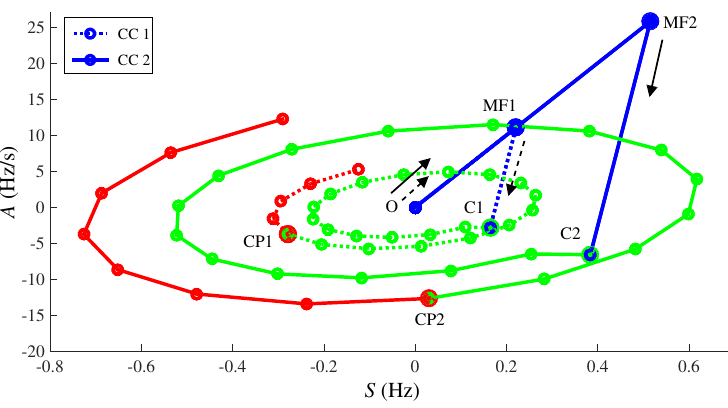
Figure 7. A k ( S k ) trajectories for contingencies CC 1 and CC 2.